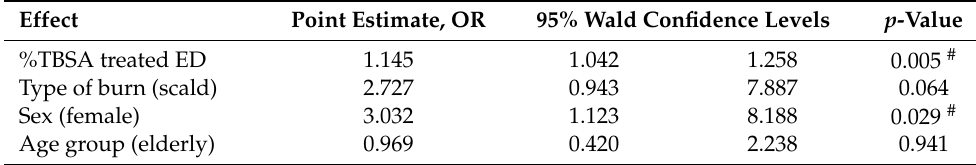
Table 3. Logistic regression predicting necessity of additional surgical intervention (n =